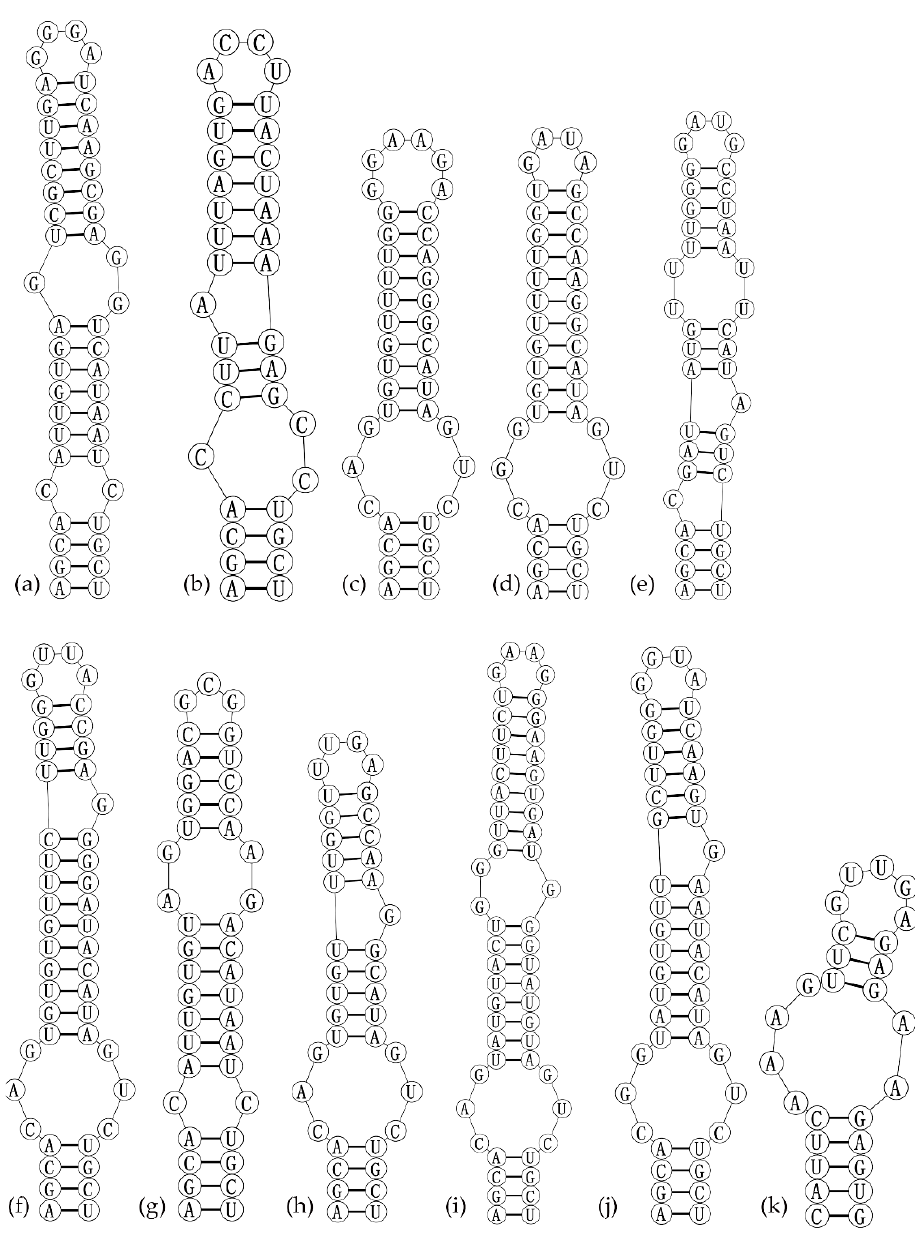
Figure 6. Secondary structure of the conserved domains of the 16S-23S ITS regions for eight representative strains of Nodosilinea . ( a – j ) Box – B helices: ( a ) N. hunanesis ZJJ01. ( b ) N. conica strain SEV4-5-c1. ( c ) N. epilithica str. Kovacik 1990/52. ( d ) N. nodulos a PCC 7104. ( e ) N. signiensis USMFM. ( f ) N. svalbardensis 3220. ( g ) N. bijugata KOVACIK1986/5a. ( h ) N. chupicuarensis PC471. (i ) N. radiophila TM S2B clone cl3. ( j ) N. ramsarensis KH-S S2.6. ( k ) V3 helix for Nodosilinea hunanesis ZJJ01.